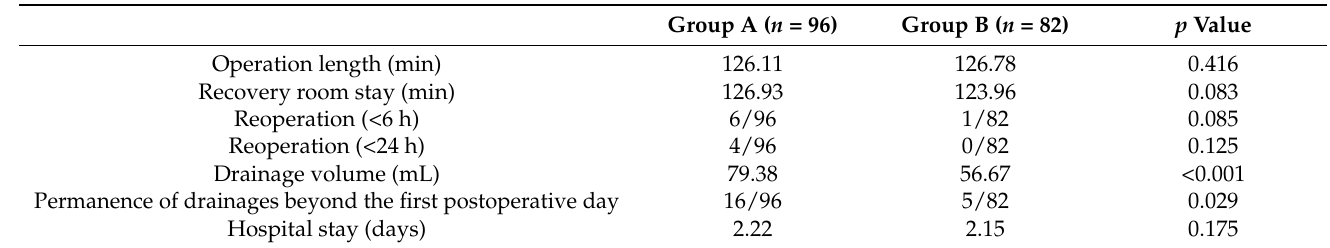
Table 2. Surgical and post-surgical data. The chi-square significance test was used. A p value less than 0.05 was considered statistically significant.